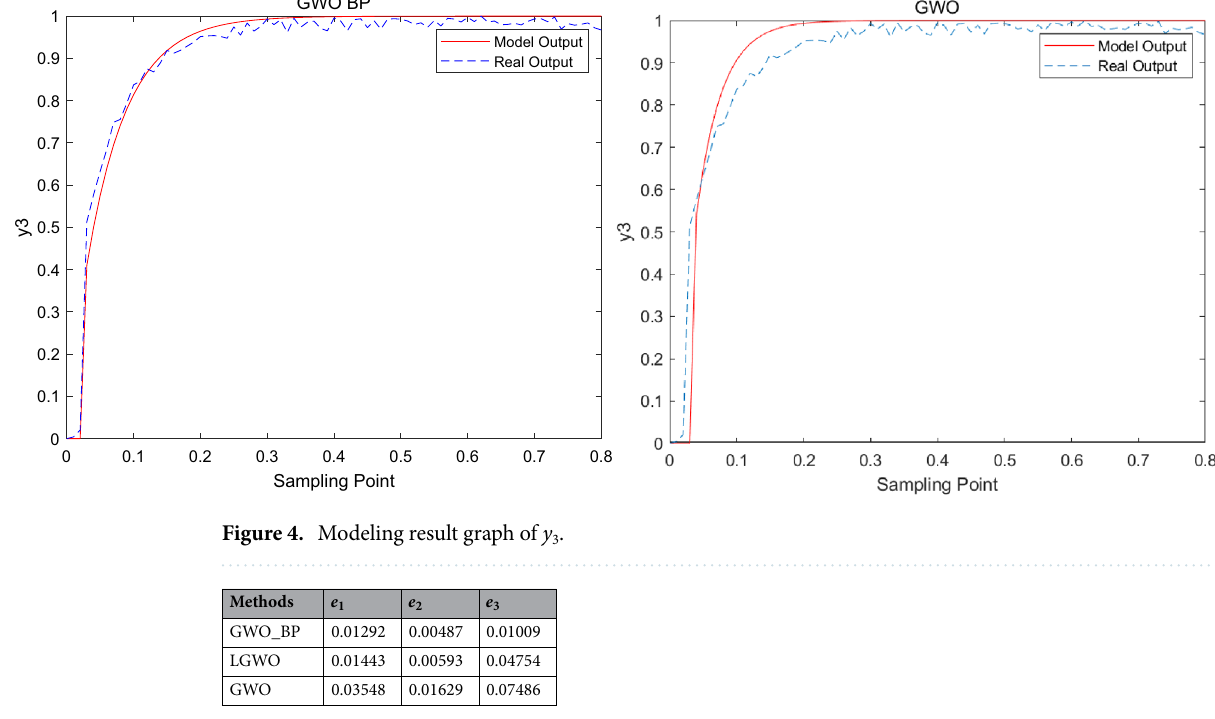
Table 6. The output